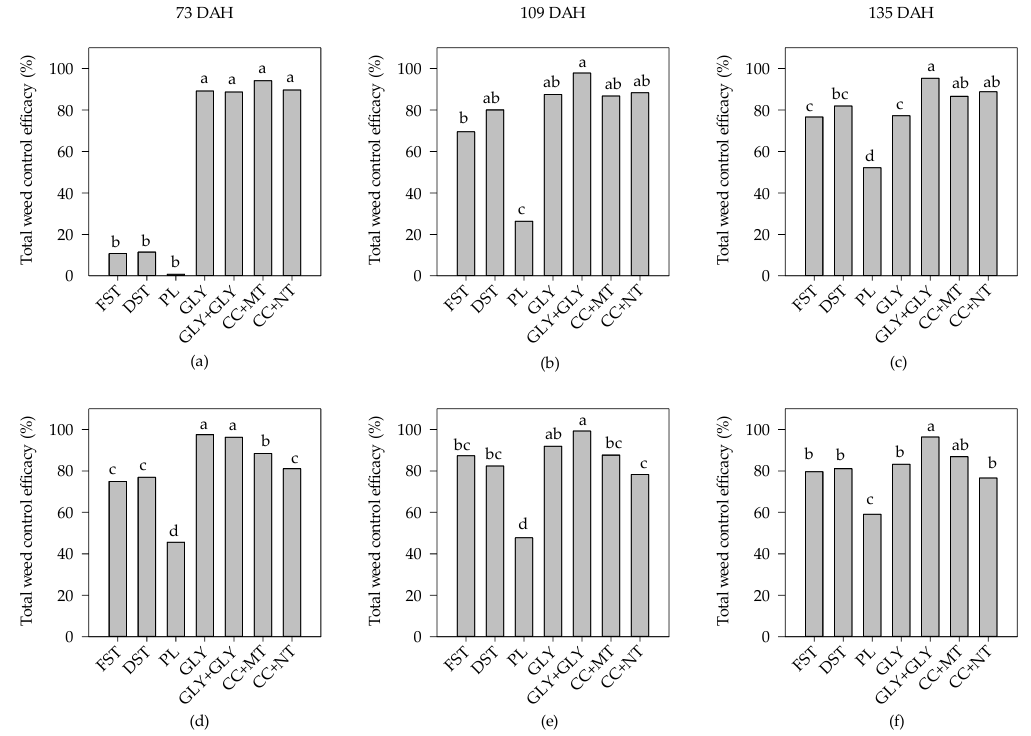
Figure 1. Average total weed control efficacy of the treatments flat soil tillage (FST), deep soil tillage (DST), ploughing (PL), single glyphosate application (GLY), dual glyphosate application (GLY+GLY), cover crop mixture + mulch-till (CC+MT), and cover crop mixture + no-till (CC+NT) at the two trials at the fields ( a – c ) Binsen and ( d – f ) Risp. ( a , d ) 73, ( b , e ) 109, and ( c , f ) 135 days after harvest (DAH). Different small letters within one graph show significant differences according to Tukey–HSD test ( p ≤ 0.05). Means with identical letters do not differ significantly.